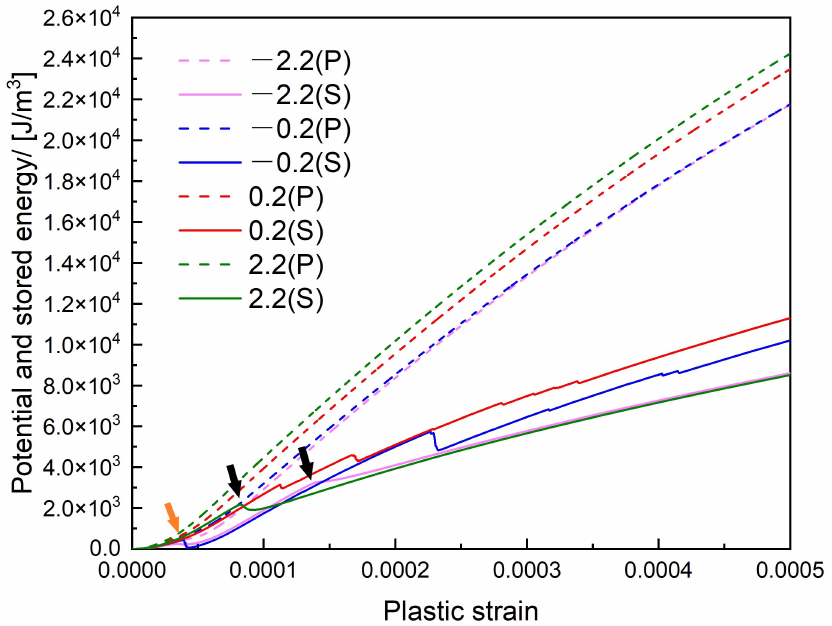
Figure 22. The potential and stored energy curve. The decrease steps in z / R = − 0.2 and z / R = − 2.2 cases due to an attractive interaction force are pointed by the orange arrow, the gentle decrease in z / R = 2.2 and z / R = − 2.2 cases due to the gradual unpinning process are pointed by the black